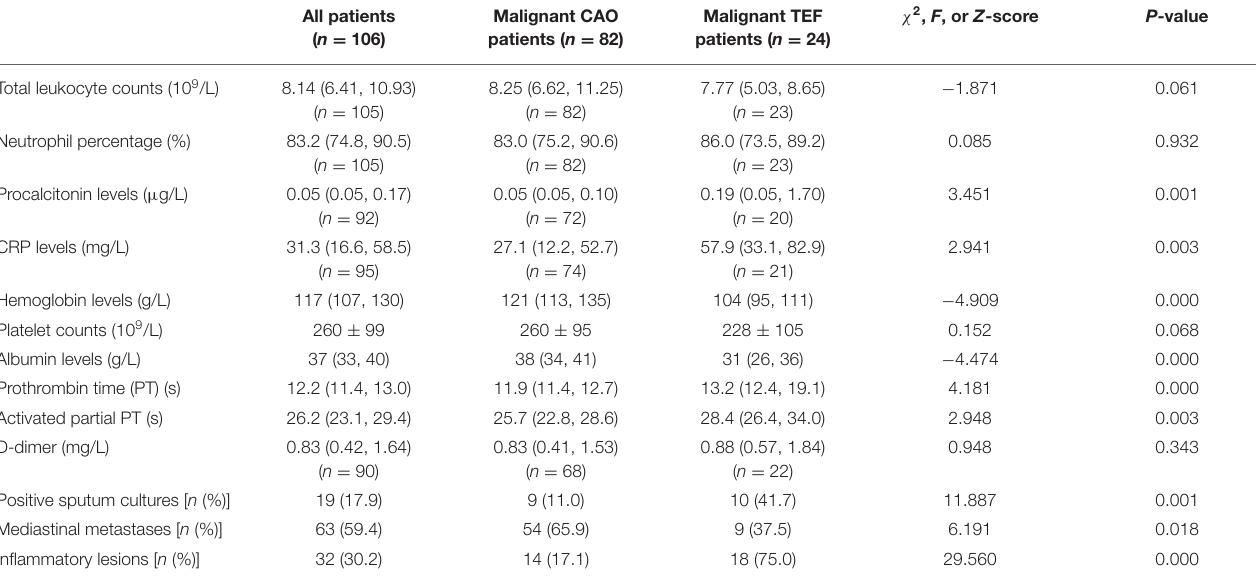
TABLE 2 | Laboratory and radiological findings between malignant CAO and malignant TEF patients.